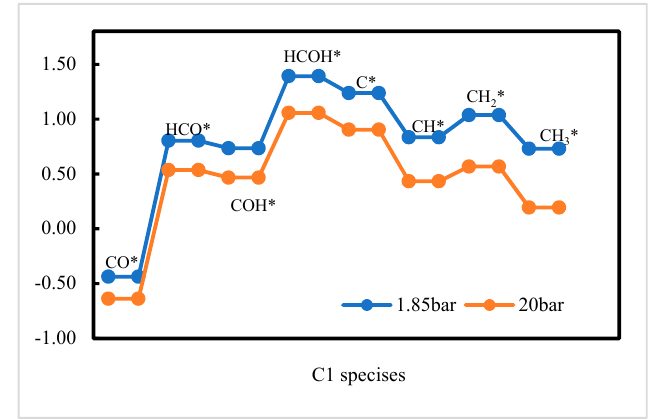
Figure 3. Free energies of each C 1 monomer, referenced to CO(g), H 2 O(g), and H 2 (g) for Fischer-Tropsch synthesis at the pressure of 1.85 bar and 20 bar with H 2 /CO = 2 and 483 K. Table 4. The combined relative free energies of two reactants.